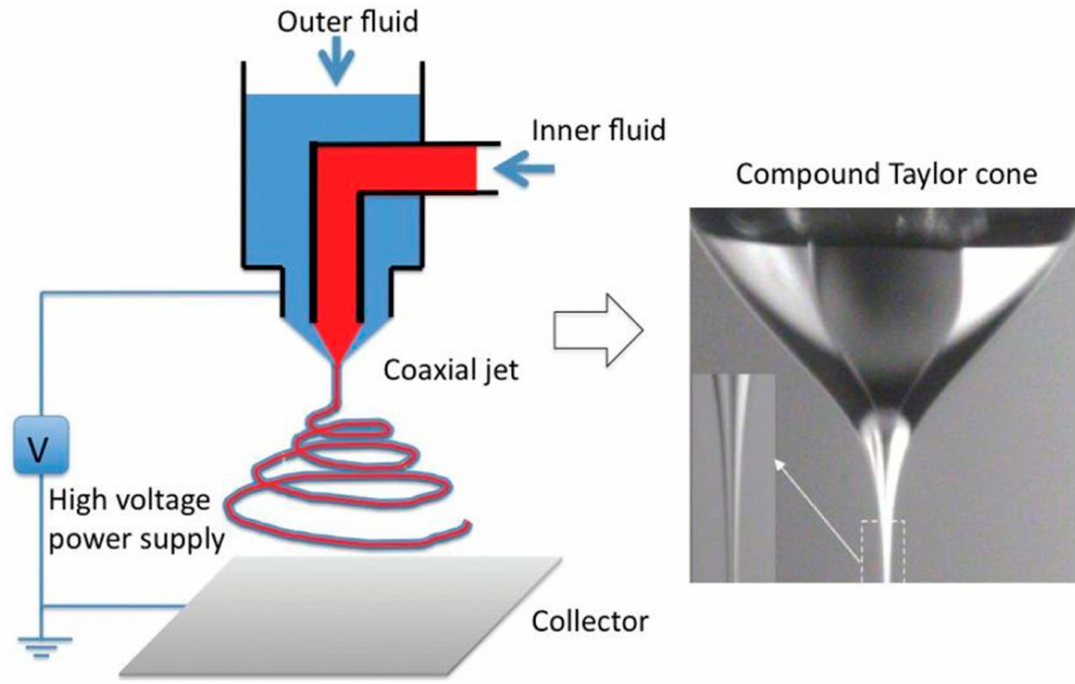
Figure 7. The basic representation of the setup for coaxial electrospinning and the change in the Taylor cone during the fabrication of common core-shell nanofibers. Reprinted with permission from [45], IntechOpen, 2010.